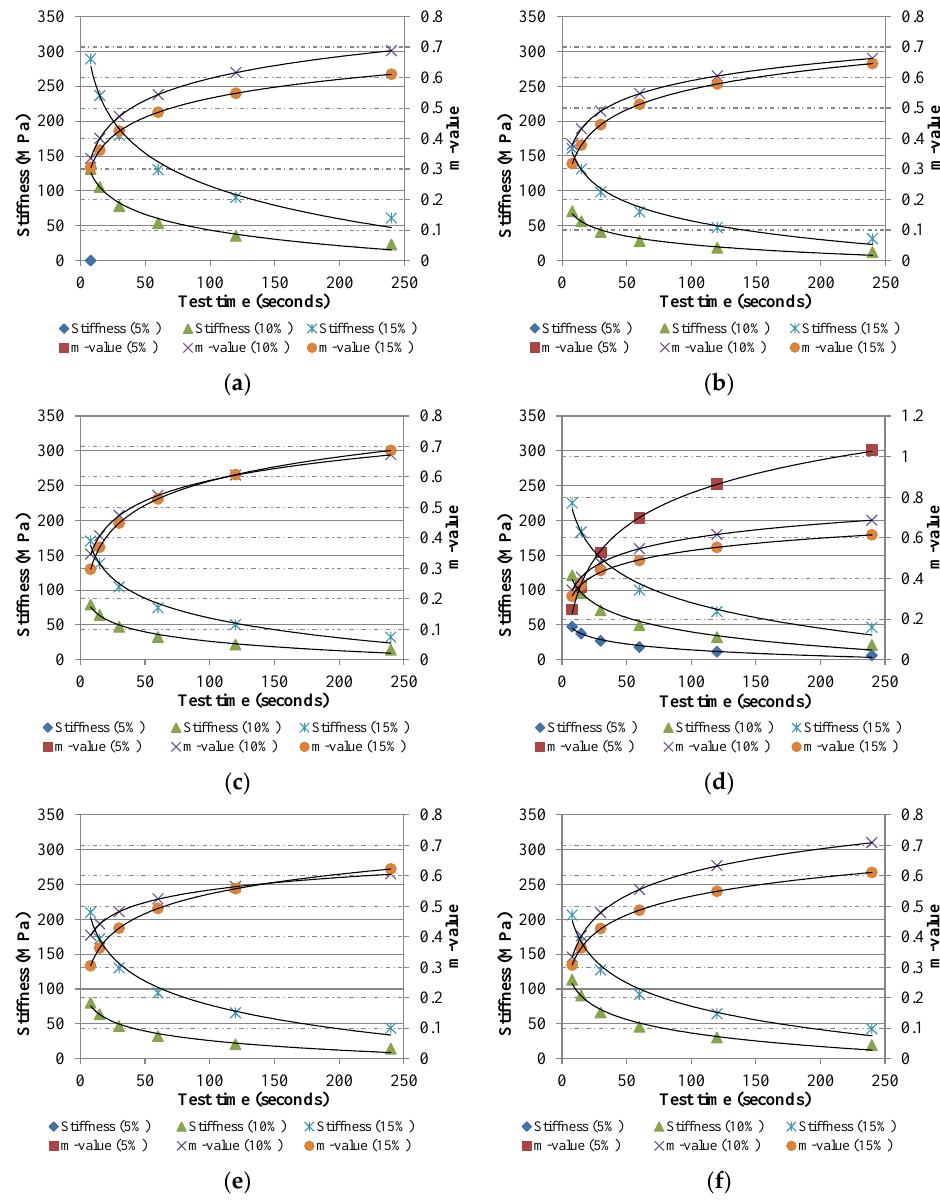
Figure 1. Stiffness values and m-values of reclaimed asphalt pavement (RAP) sources A–F modified with virgin binder PG 58-28 at −6 °C, ( a – f ) RAP sources A–F. A–F the names of RAP source in this study.